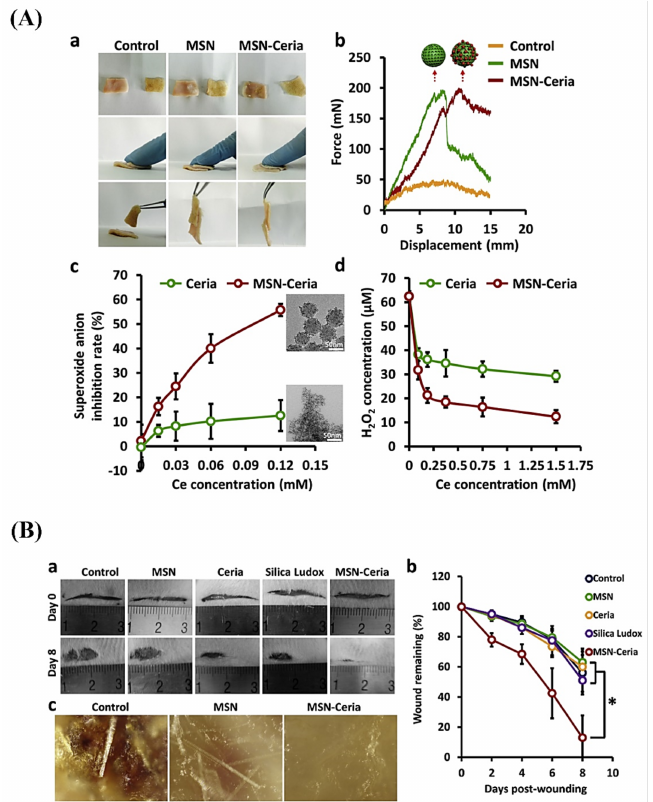
Figure 3. ( A ) Aqueous solutions of MSN and MSN-ceria can serve as an efficient tissue adhesive capable of holding the two skins together ( a ), normalized force-displacement curves for lap joints of two skins glued by different groups ( b ), neutralization of superoxide anions by MSN-Ceria in a dose-dependent manner in comparison with ceria aqueous suspension ( c ), and Scavenging activities of H 2 O 2 by MSN-Ceria nanocomposites and ceria nanocrystals ( d ). ( B ) Representative images of the wound healing process during 8 days in vivo experiments ( a ), quantification of wound repair kinetics expressed as a percentage of the initial wound length ( n = 5) ( b ), and microstructure of wound surfaces on day 22 after wound healing imaged using Nikon AZ100 stereomicroscope ( c ). *, p < 0.05. Reproduced with permission from ref [85]. Copyright 2018